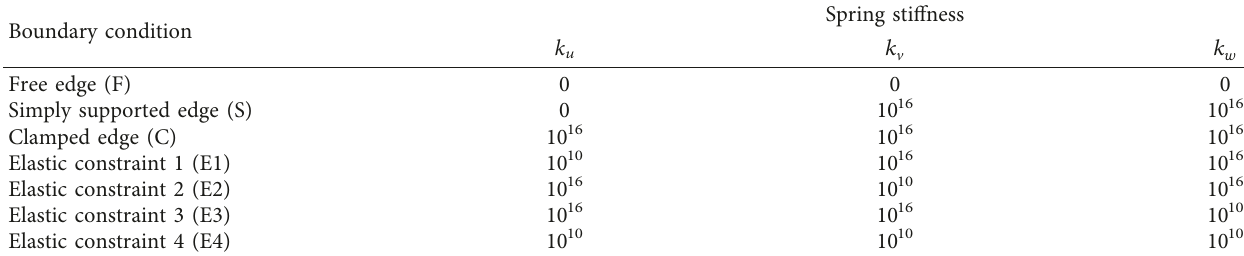
Table 5: Values of spring stiffness for three types of classical boundary conditions and four kinds of elastic constraint.